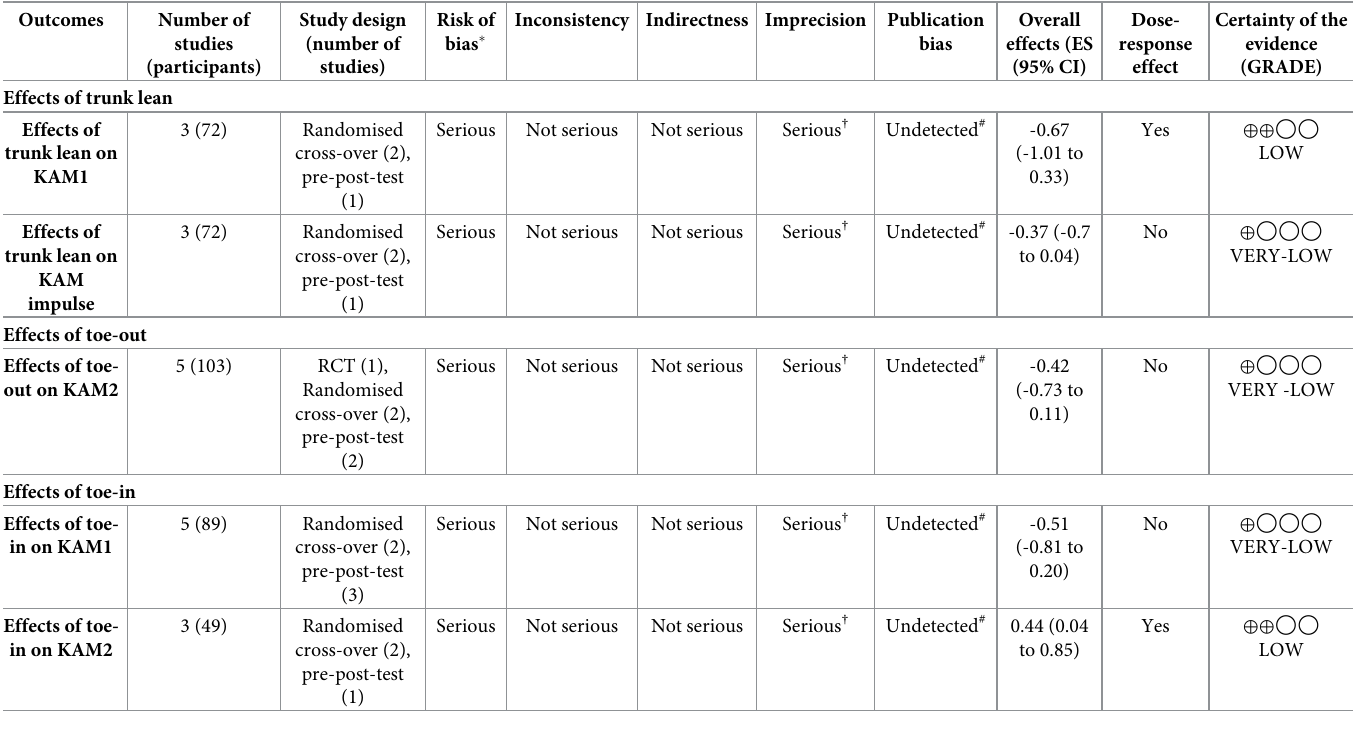
Table 6. The quality of evidence on indicators of medial knee joint load assessed according to the GRADE